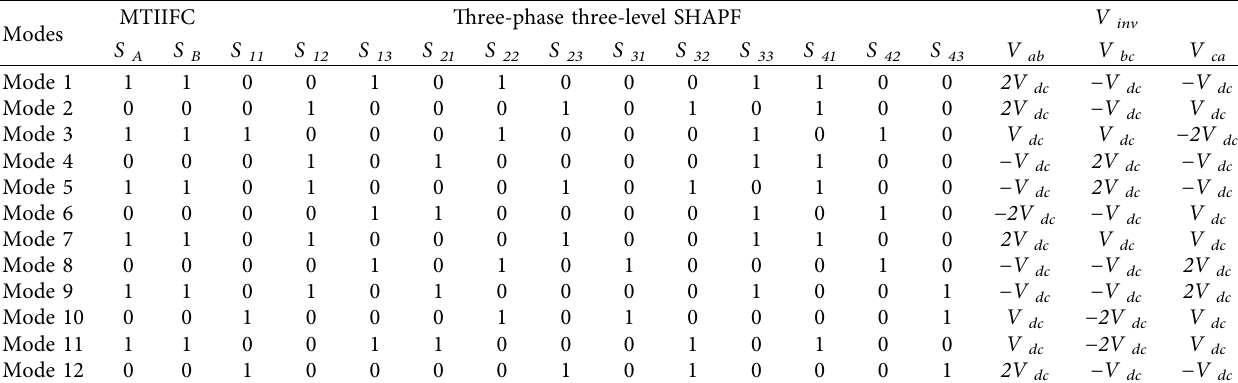
Table 1: Switching table for the proposed